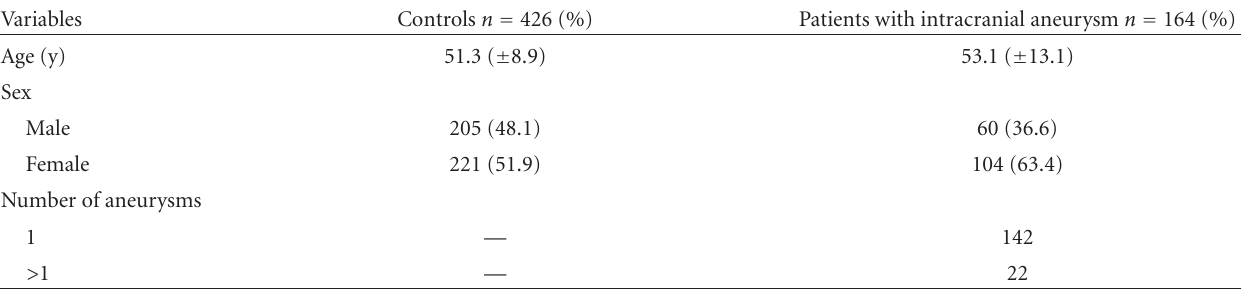
Table 1: Demographics of the patients with intracranial aneurysm and controls.